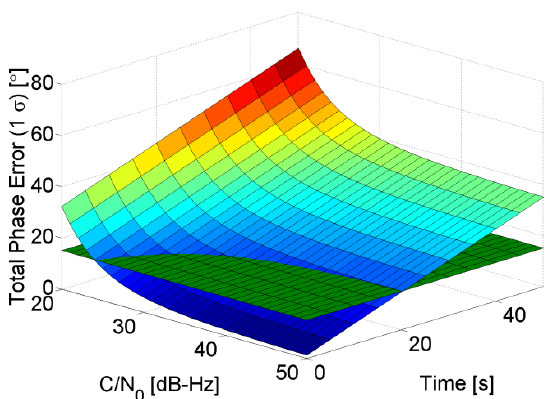
Figure 3. Assisted PLL phase error when B b  = 2,000 deg/h. ib